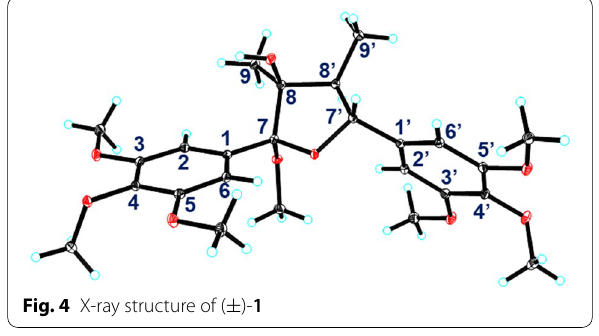
Fig. 4 X‑ray structure of (